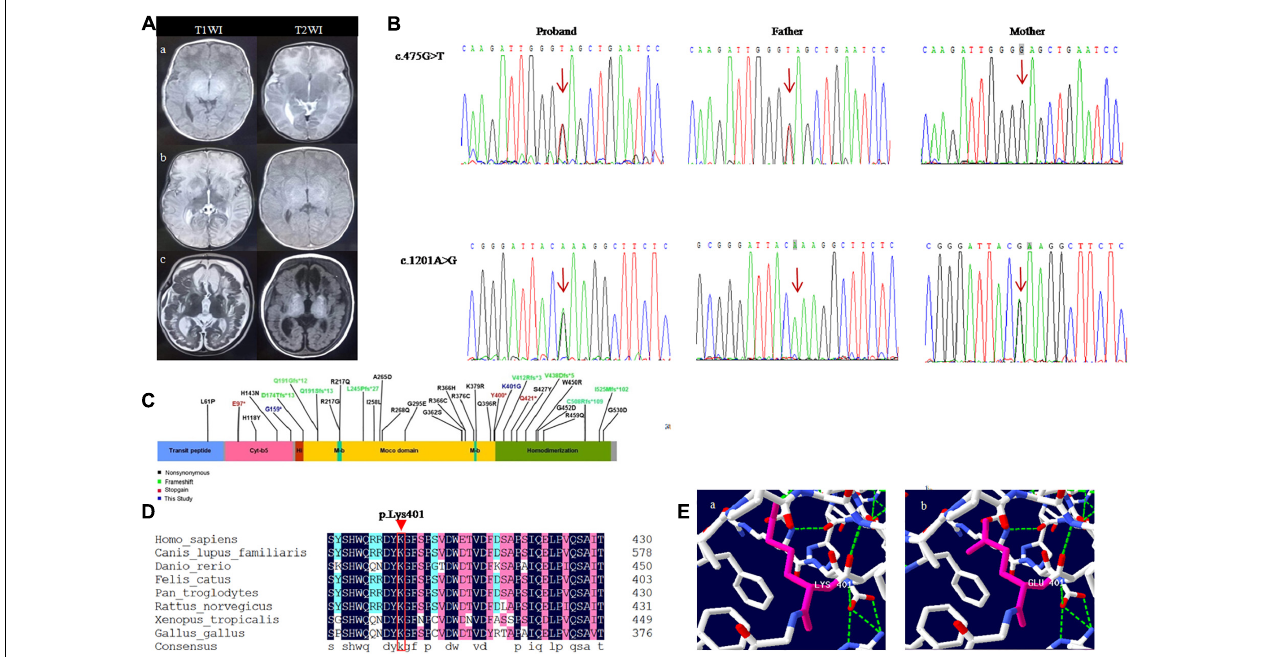
FIGURE 1 | Shows the neuroradiological features and genetic results of the patient. (A) Brain MRI of the follow-up of a child with sulfite deficiency enzyme. (Aa) MRI findings were normal at the age of 18 days; (Ab) 1 month and 3 days after birth, MRI showed high signal on T2WI and low signal onT1WI in bilateral cerebral hemispheres, basal ganglia, and thalamus, DWI showed high signal, and ADC showed low signal; (Ac) Follow-up to 5 months, MRI showed polycystic encephalomalacia and atrophy with bilateral subdural effusion. (B) Sanger sequencing analysis of SUOX gene exon 6 in genomic DNA from the family. (C) Linear map of the mutations in SUOX . (D) Conservation of the p.Lys401Glu variant found in this study. (E) Amino acid and conformation changes of the p.Lys401Glu polypeptide wild-type (Ea) and mutant type (Eb)